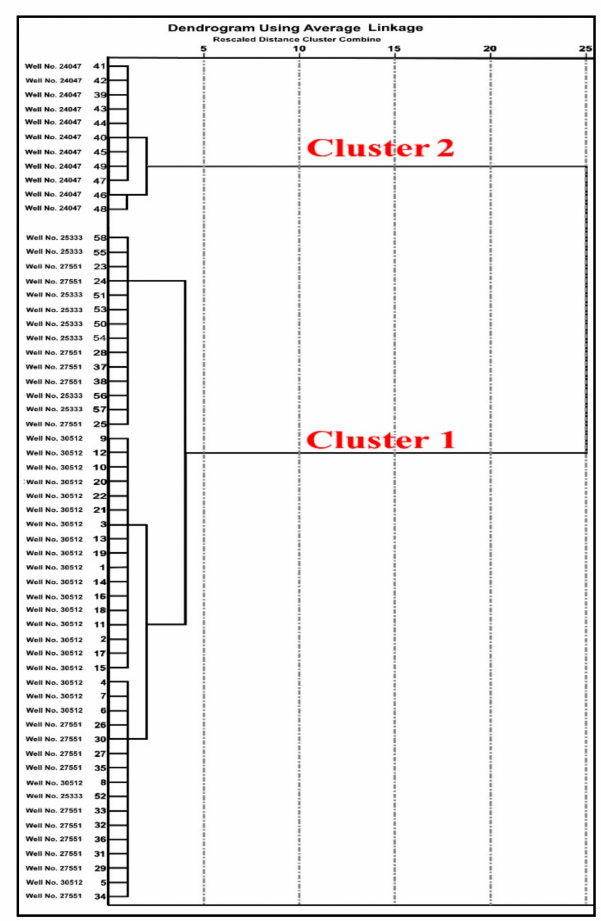
Figure 7. Dendrogram based on hierarchical cluster analysis and average linkage (between